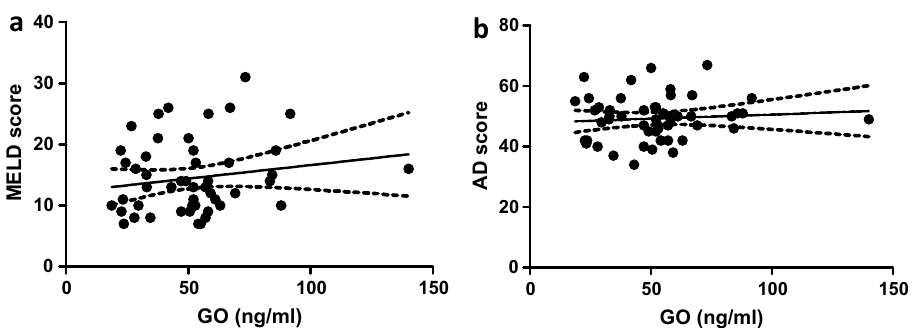
Figure 5. Circulating glyoxal serum levels correlated with neither the MELD score (effect size r = 0.151) ( a ) nor the AD score (effect size r = 0.073) ( b